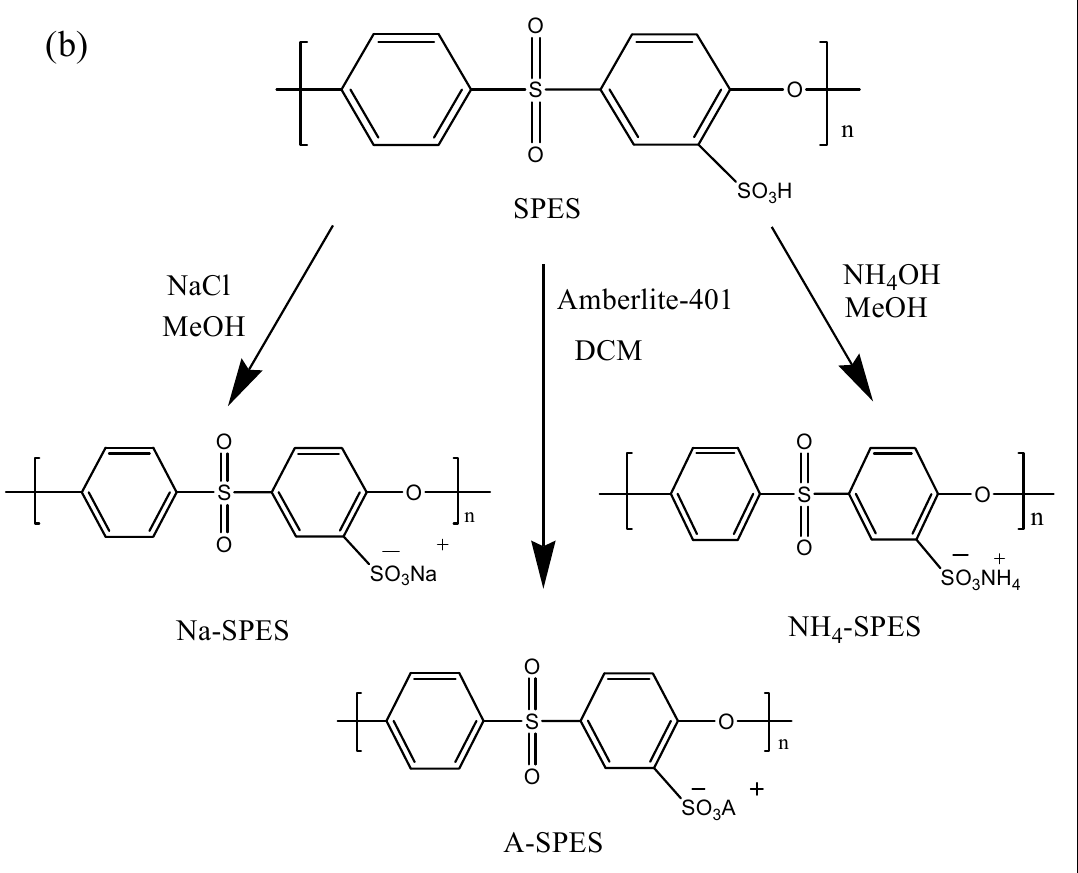
Figure 1. ( a ) Preparation of SPES. ( b ) Preparation of modified SPES membranes (Na-SPES, NH 4 -SPES, and A-SPES).